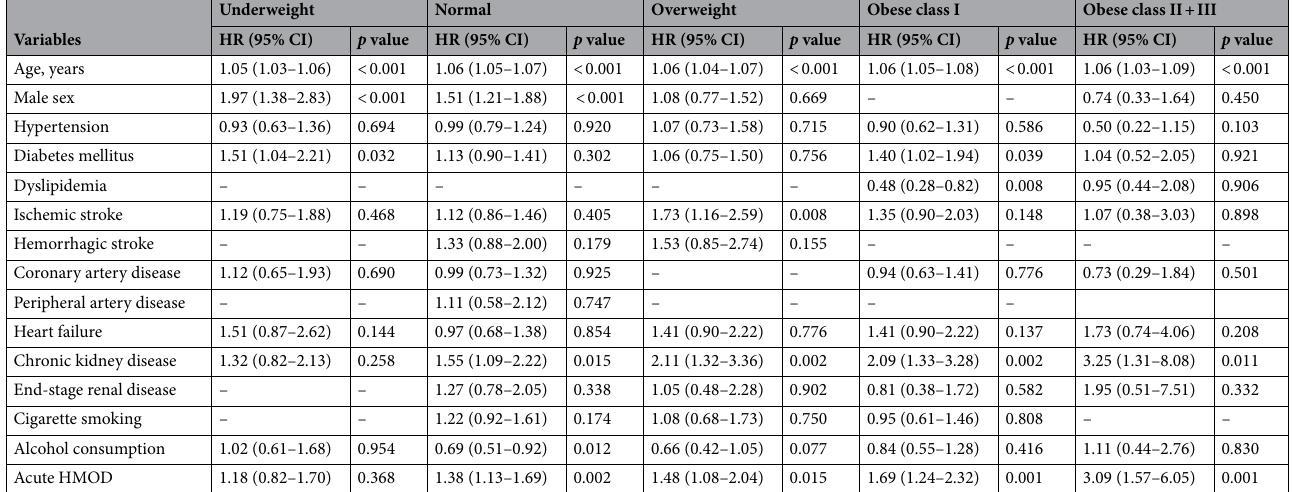
Table 4. Predictors for 3-year all-cause mortality of each BMI group. The body mass index was < 18.5 in the underweight group, 18.5 to 22.9 in the normal group, 23.0 to 24.9 in the overweight subjects, 25.0 to 29.9 in the obese class I group, and ≥ 30.0 in the obese class II + III group. BMI, body mass index; HR, hazard ratio; CI, confidence interval; HMOD, hypertension-mediated organ